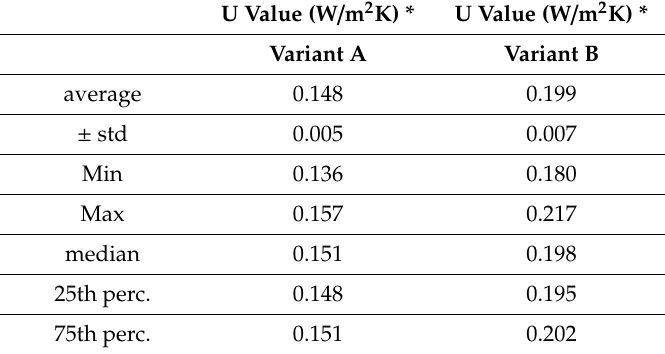
Table 3. Description of measured U values after the stabilisation of the thermal condition of the sample. U Value (W / m 2 K)